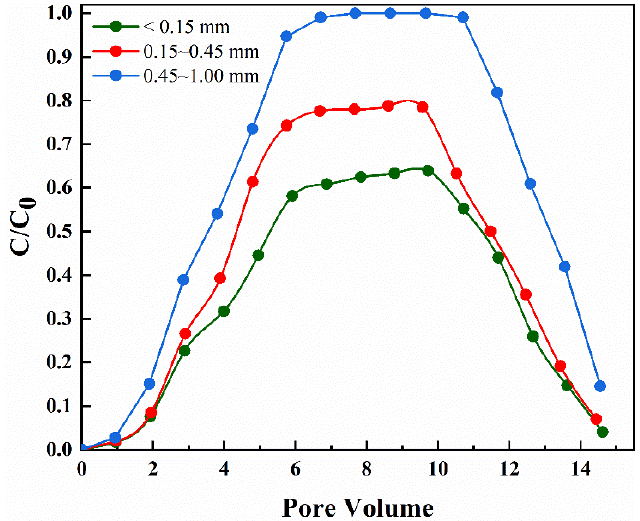
Figure 5. The influence of the particle size on the vertical migration of PHE in soil.